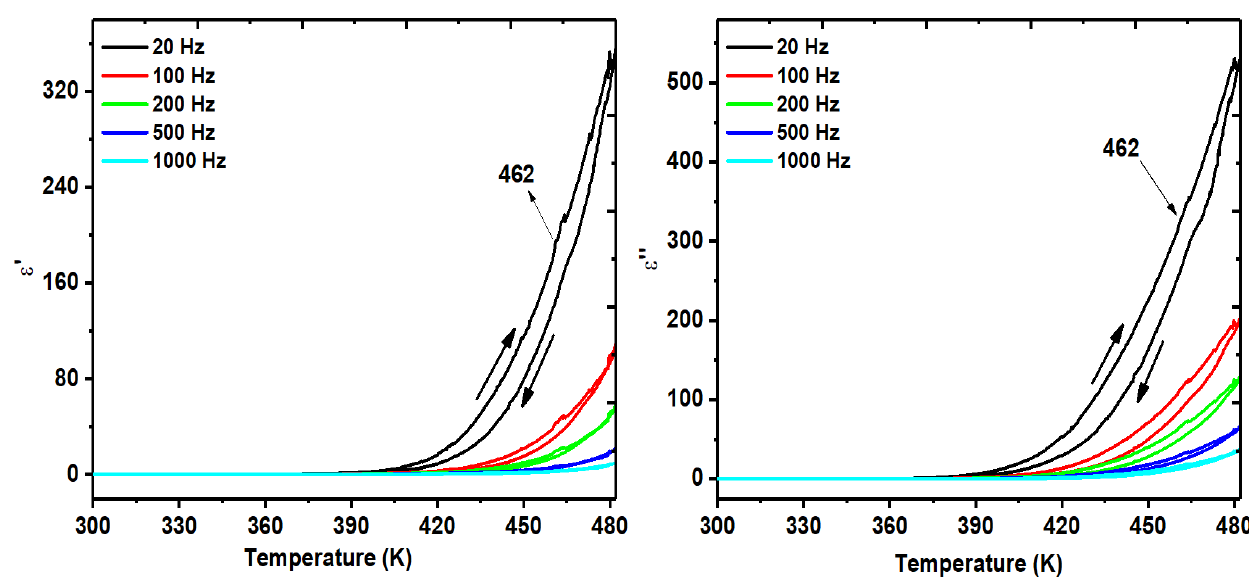
Figure 10. Dielectric permittivity of MDABCO-NH 4 I 3 nanocrystals embedded in electrospun fibers, MDABCO-NH 4 I 3 @PA66a showing the ferroelectric – paraelectric phase transition at 462 K. In this figure, the up and down black arrows indicate respectively the heating and cooling cycles.